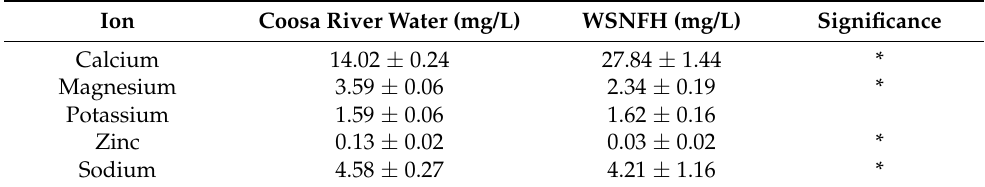
Table 1. Ion concentrations (mg/L) measured by Inductively Coupled Plasma Optical Emission spectrometry (ICP:OES) in Coosa River water and WSNFH water ( n = 11–14). * indicates a significant difference between treatments (unpaired t -test, two-tailed, p <